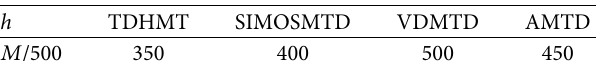
Table 15: Comparison of the NFE of TDHMT with the NFE of other existing methods, namely, SIMOSMTD, VDMTD, and AMTD for Example